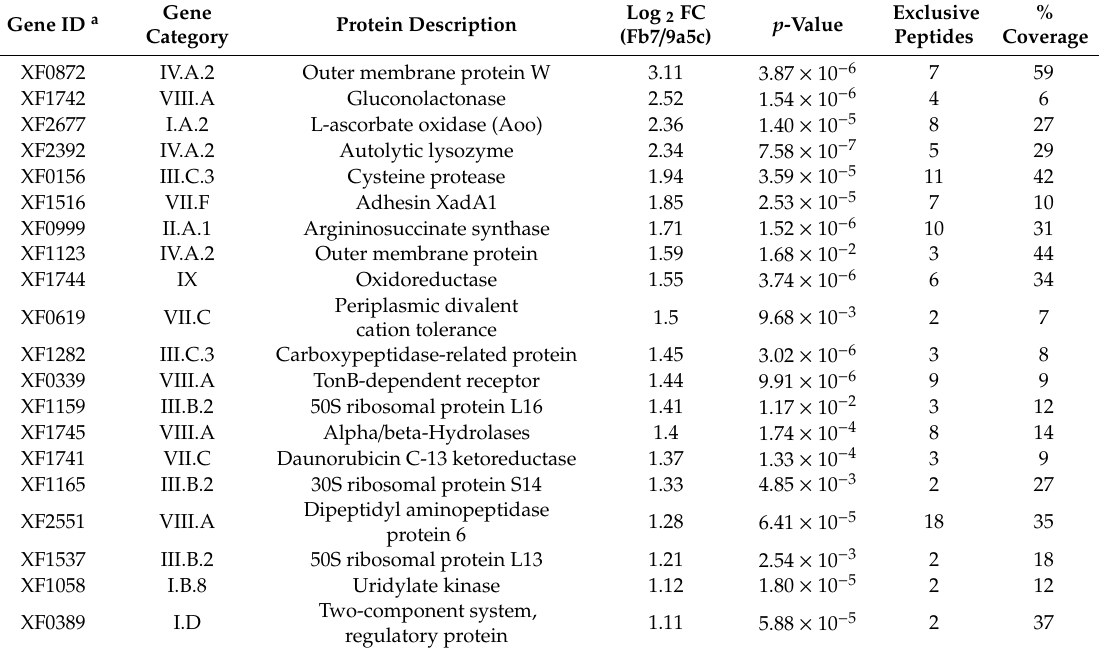
Table 1. Top 20 cellular extract proteins with higher abundance in X. fastidiosa subsp. pauca strain Fb7 over strain 9a5c of the same species.